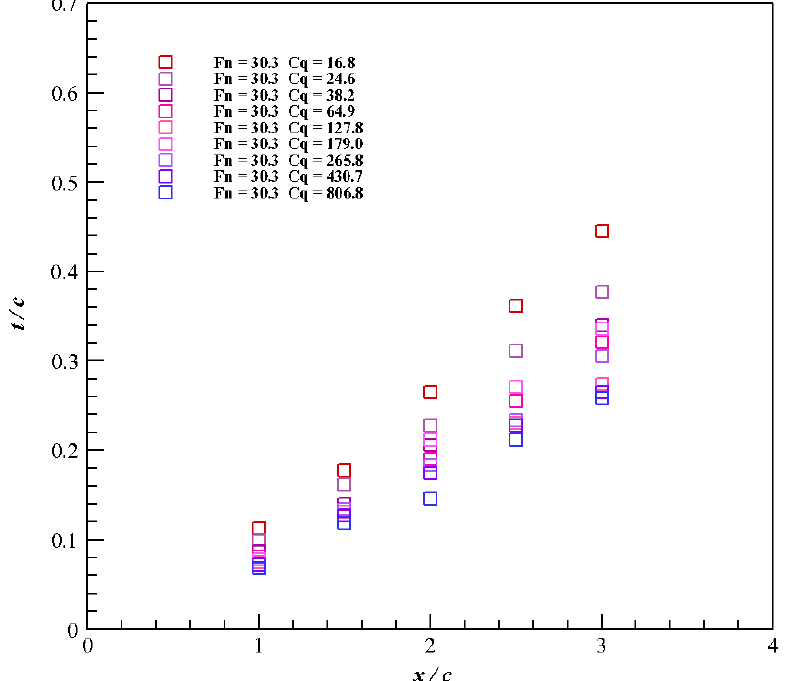
Figure 17. The non-dimensional jet thickness, t / c , variation along the non-dimensional stream-wise distance, x / c , for various non-dimensional air injection rates, C q , at Reynolds number, Re air =